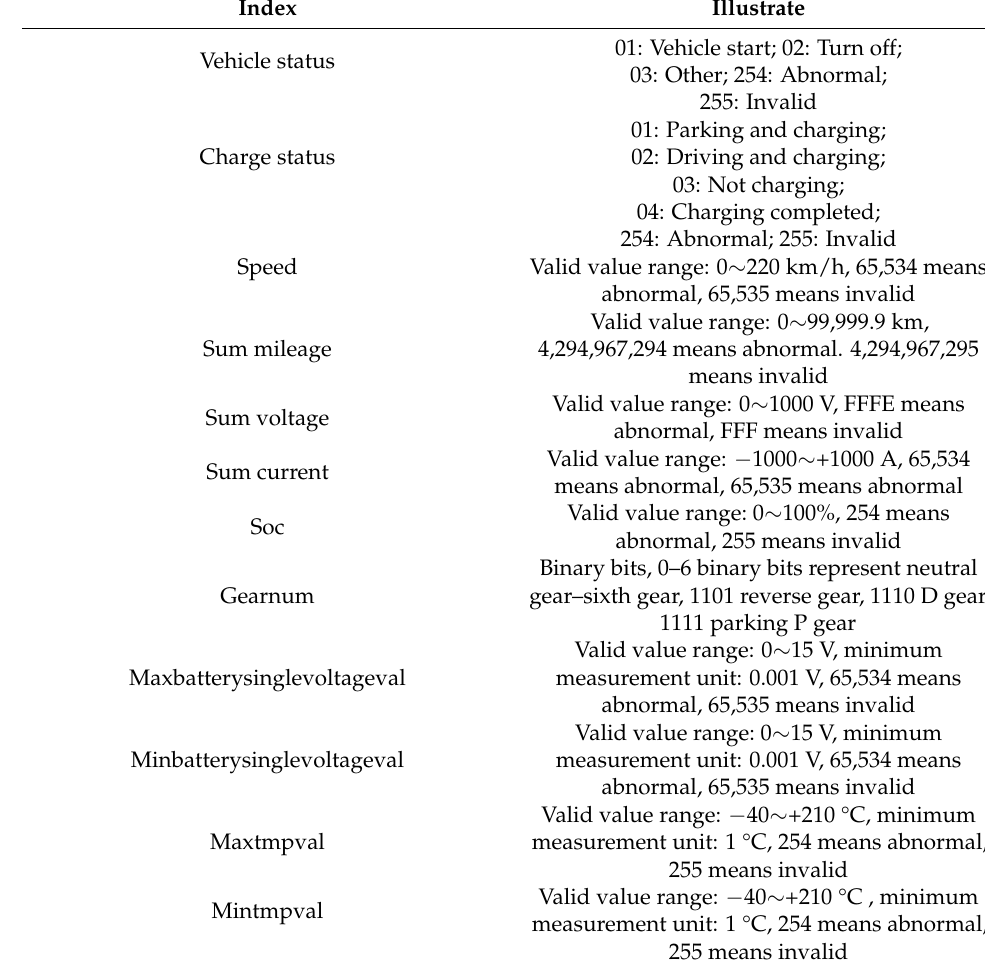
Table 5. Data retained after